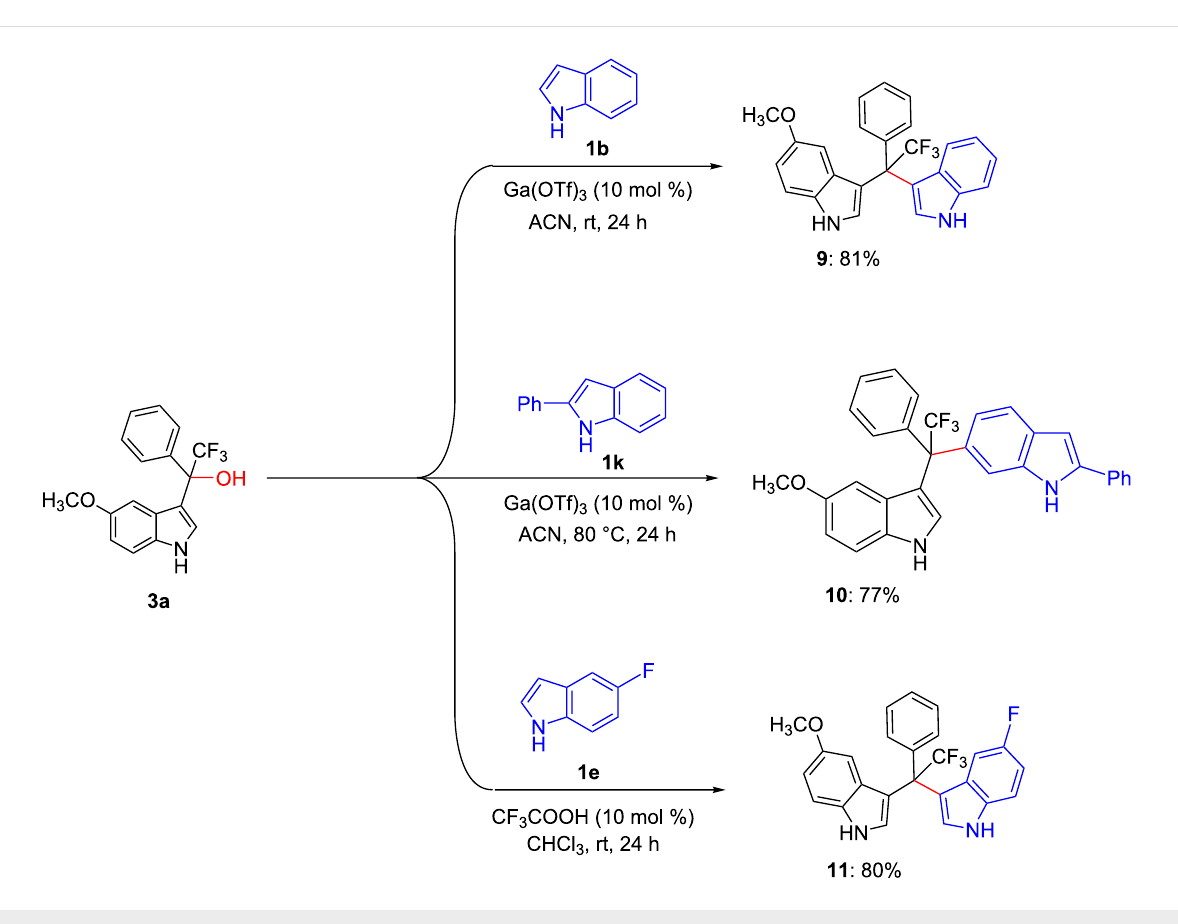
Scheme 2: Synthesis of trifluoromethylated unsymmetrical 3,3'- and 3,6'-DIMs ( 9–11